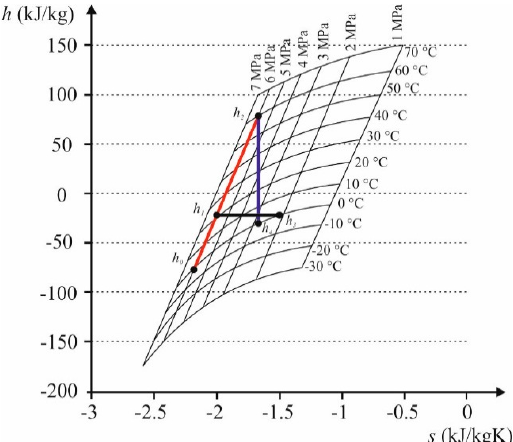
Figure 1. Comparison of isenthalpic throttling and polytropic expansion of natural gas depicted in a Mollier diagram, (gas pressure before reduction: 6 MPa, gas pressure after reduction: 2.5 MPa), 0–1–2: isobaric heating, 1–3: isenthalpic throttling, 2–4: polytropic expansion.